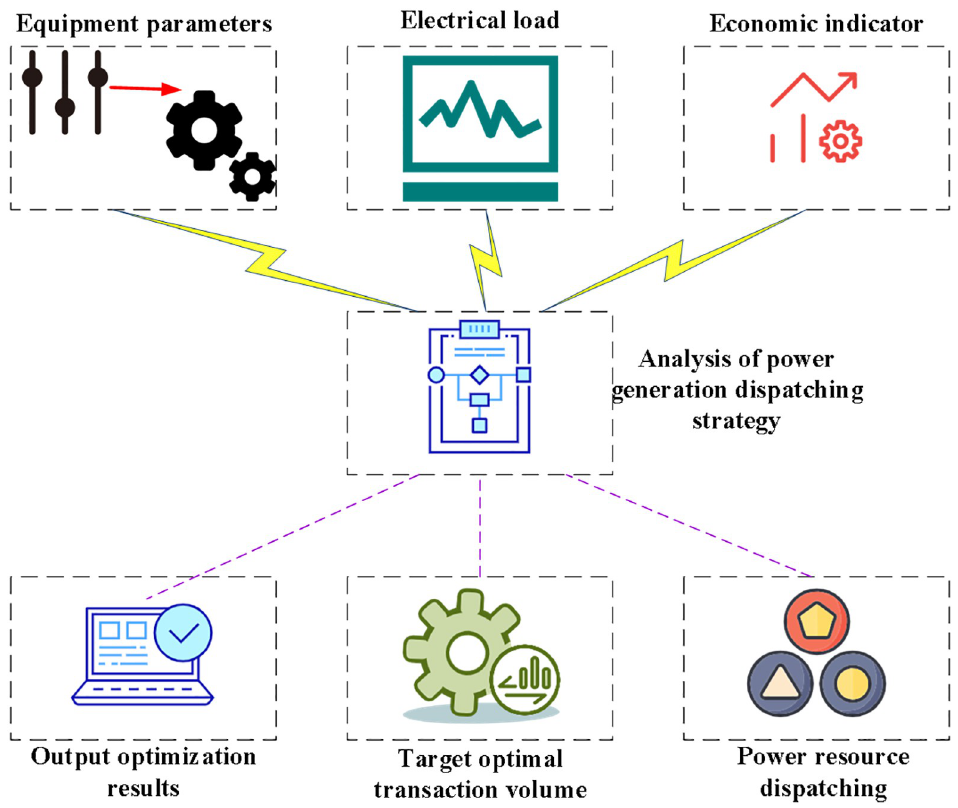
Fig 1. Structural analysis of the generation dispatch strategy in the electricity